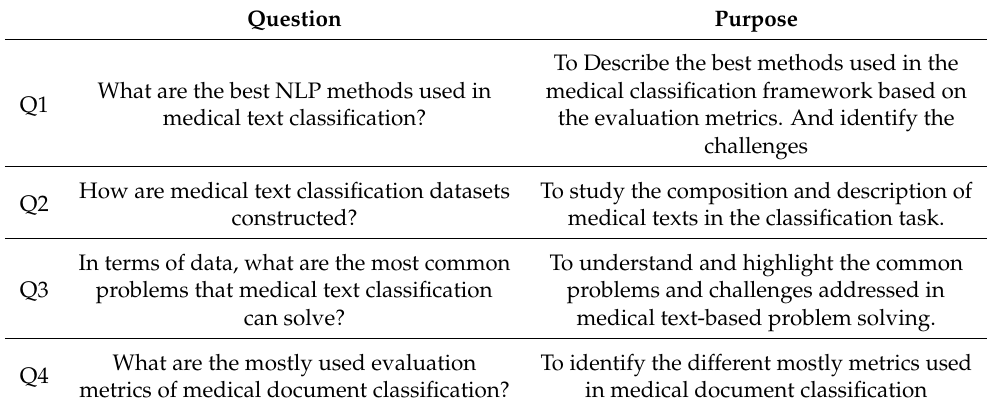
Table 1. Research questions and